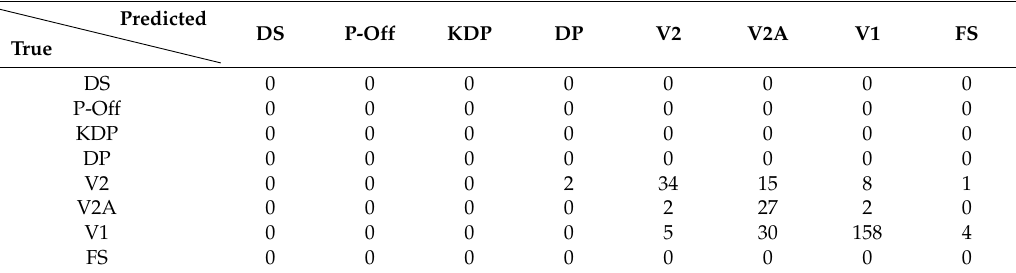
Table A5. Confusion matrix for the natural course, skating style validation set of skier 1 when using the sports biomechanics configuration of sensors.